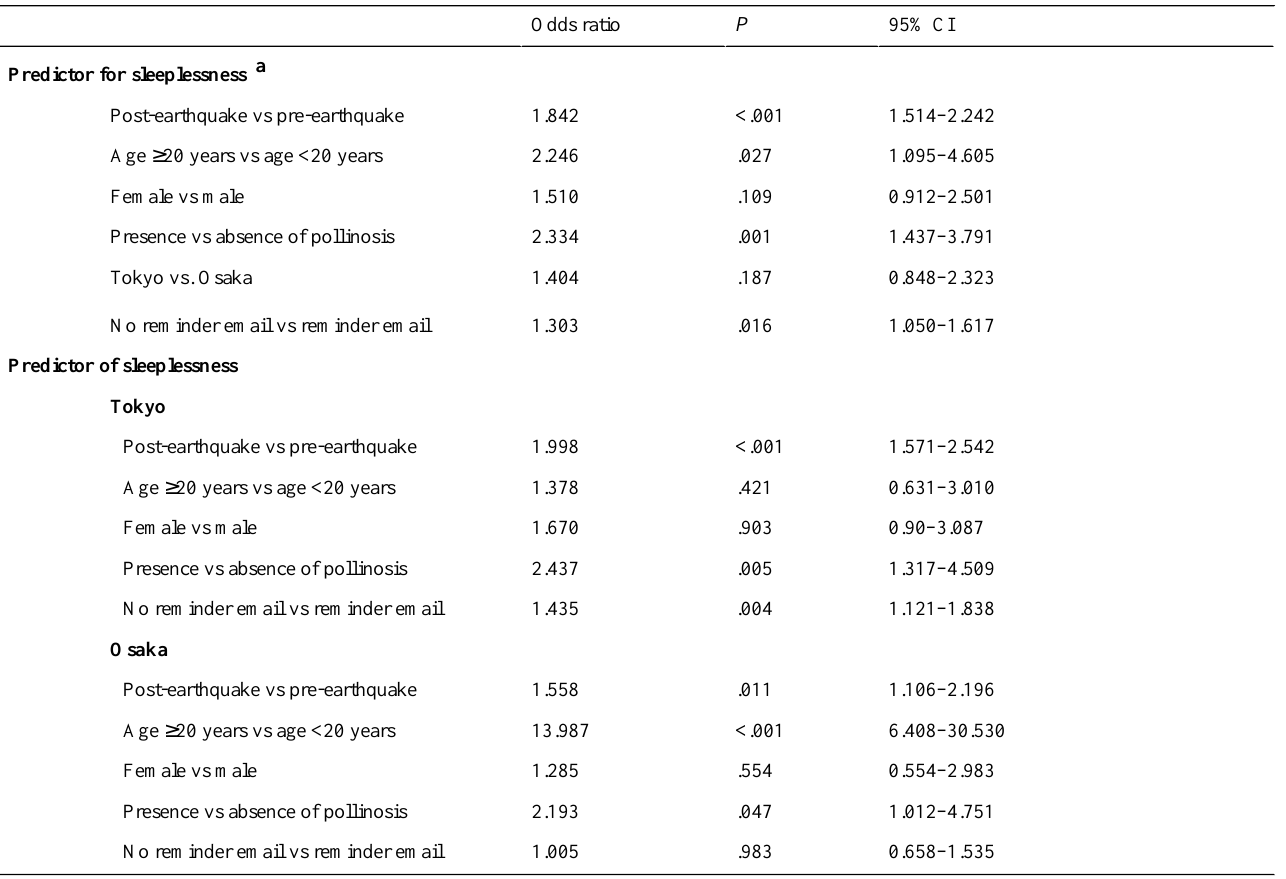
Table 3. Multivariate analysis of factors associated with the prevalence of